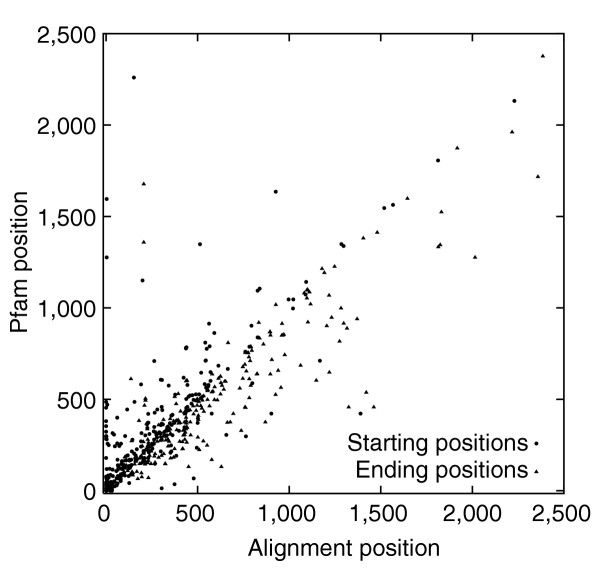
Association between recombined sequence domains and Pfam structural domains. The horizontal axis shows the starting and ending positions of the sequence domains in recombined genes (in amino acids, relative to the translation start site of the gene). The vertical axis shows the starting and ending positions of the Pfam domain closest to each recombined sequence domain.